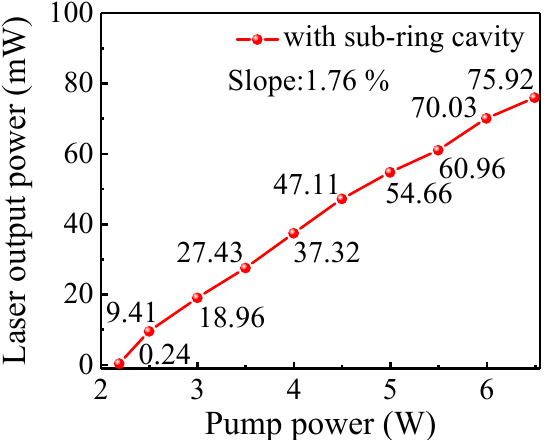
Figure 9. Output power variations of the laser with different pump powers.